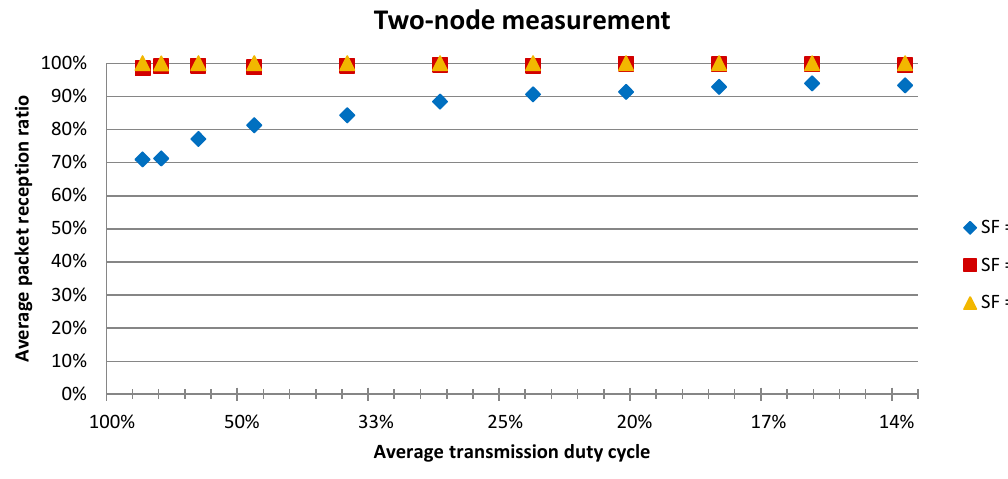
Figure 11. Packet reception ratio for the two-node setup under various traffic loads with spreading factors of 8, 16 and